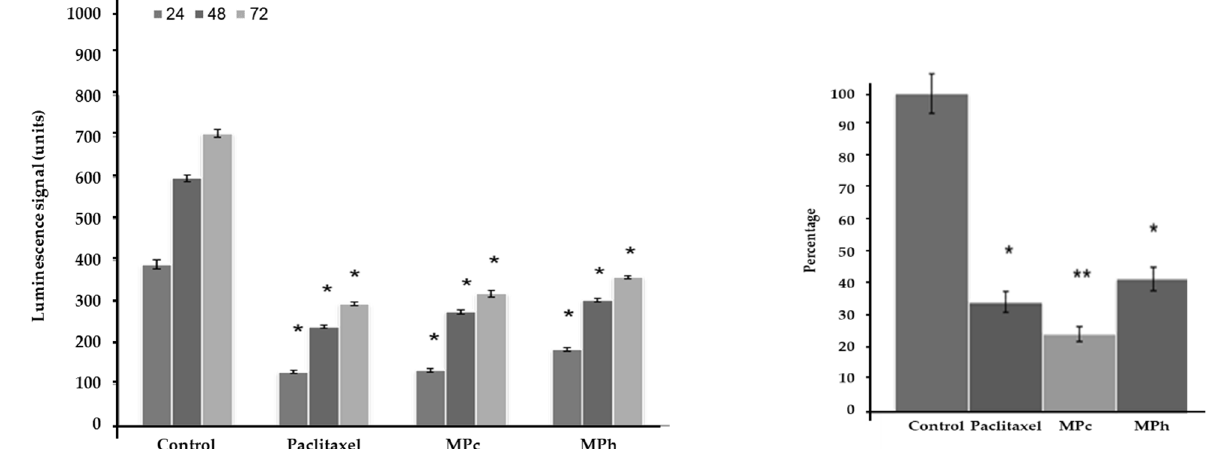
Figure 6. Depolarization of mitochondrial membrane potential (MMP) of PC3 prostate cancer cell lines was induced by the active extracts of Marantodes pumilum . PC3 cell lines were treated with the IC50 of MPc and MPh or Camptothecin (Camp) for 6 hours. ( A ) Representative MMP profiles of flow cytometry for active plant extract-treated PC3 cells. ( B ) Quantification of depolarization intensity. The data are means ± SEMs ( n = 3). * p < 0.05 and ** p < 0.01, against control, were determined via unpaired t -test.